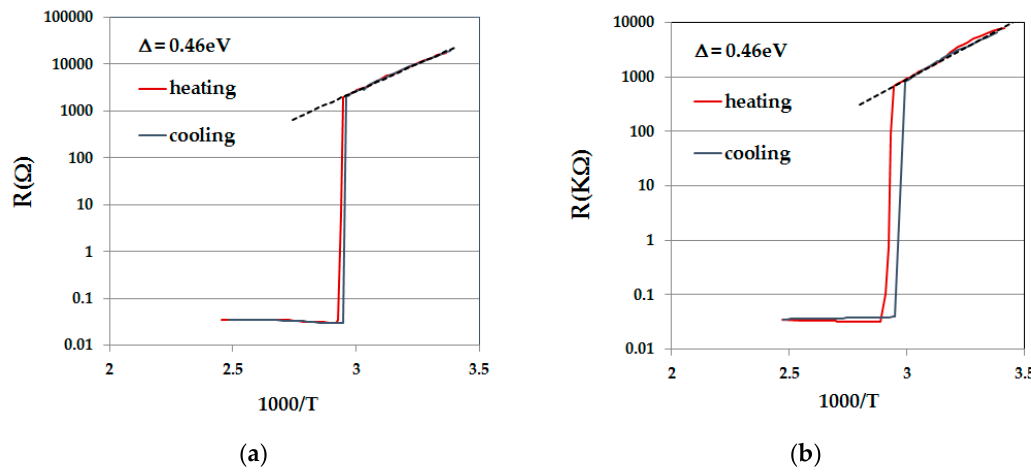
Figure 1. R(1/T) for samples ( a ) P4 (measured in the four-probe configuration) and ( b ) P2 (measured in the two probe configuration).